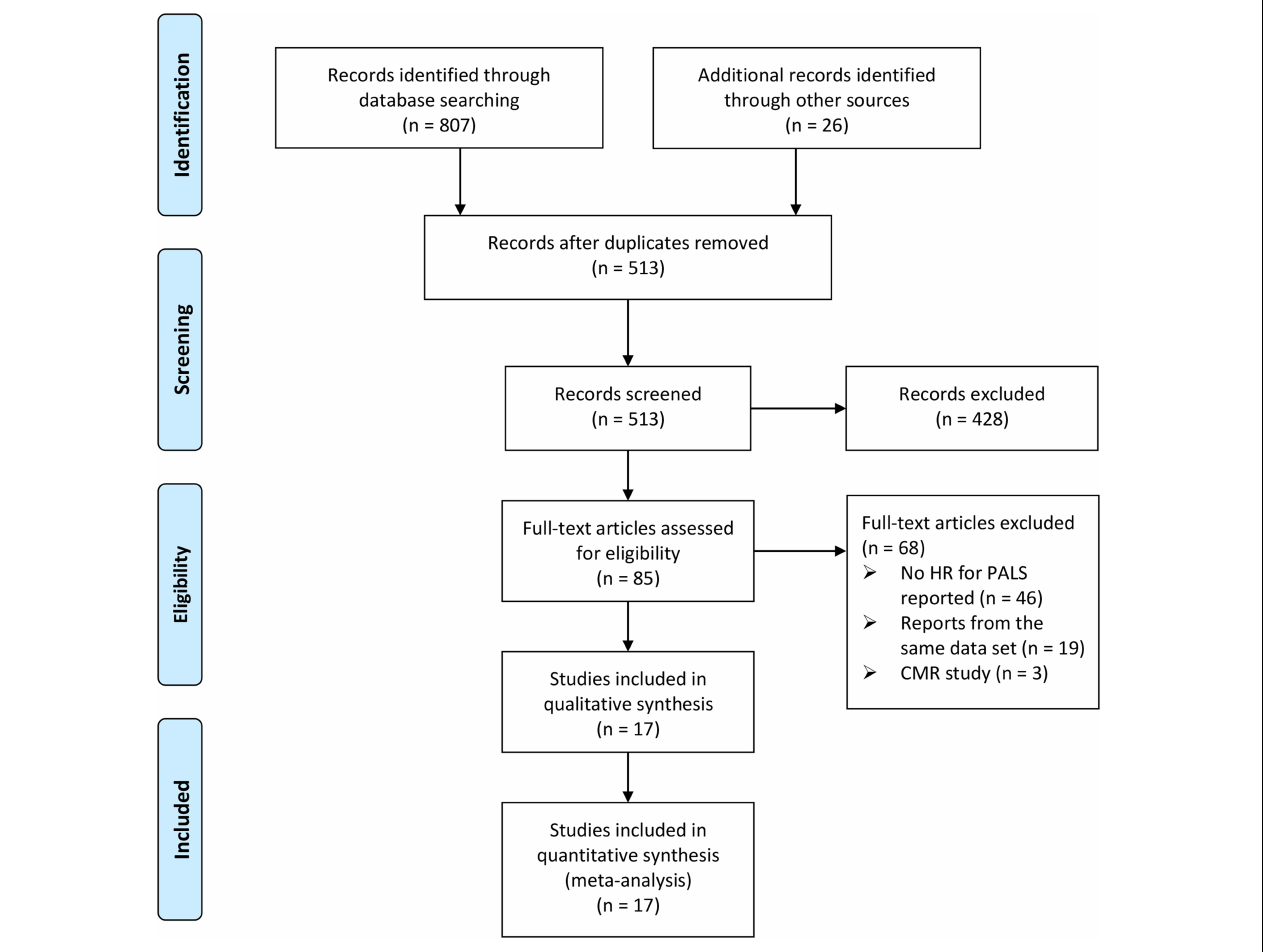
FIGURE 1 | The Preferred Reporting Items for Systematic Reviews and Meta-analysis (PRISMA) flowchart of the study selection